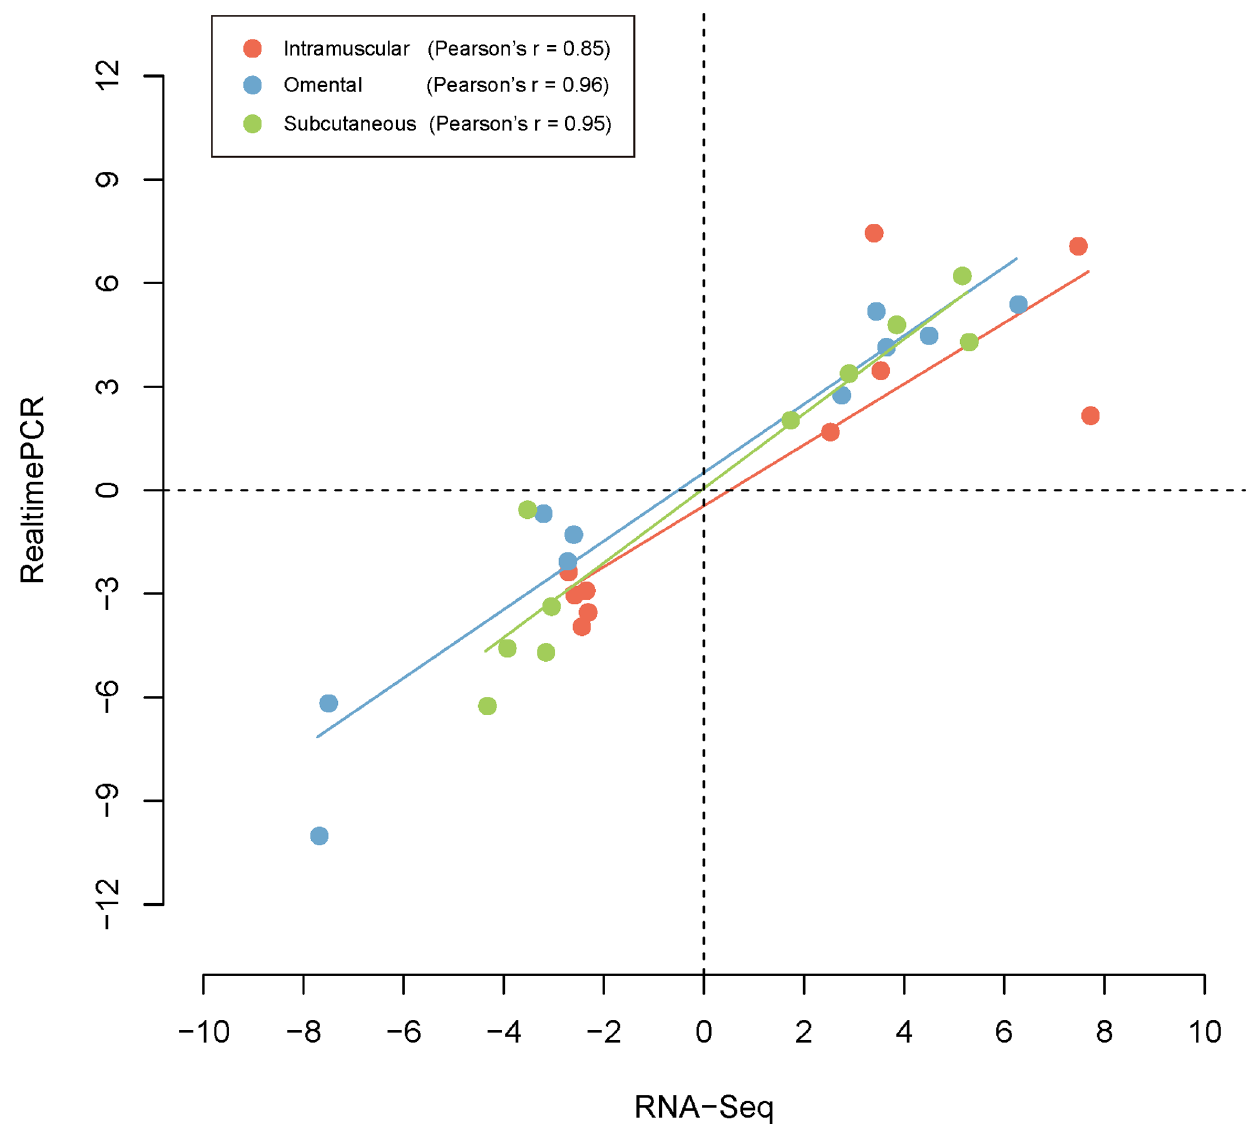
Figure 2. The correlation of fold changes in gene expression between the RNA seq and qRT-PCR.